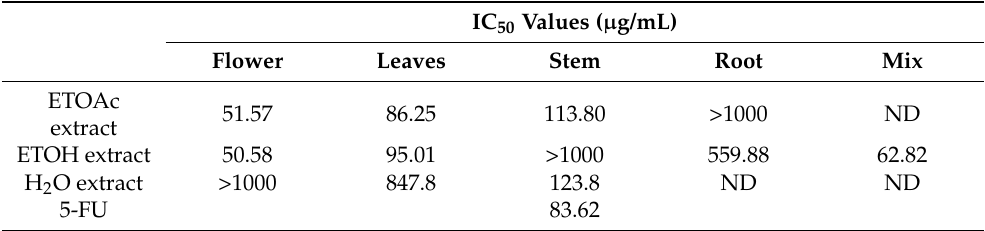
Table 1. IC 50 values of the extracts of different segments and the mixture of N. paulsenii Briq. on lung cancer cell line A549. IC 50 Values ( µ g/mL) Flower